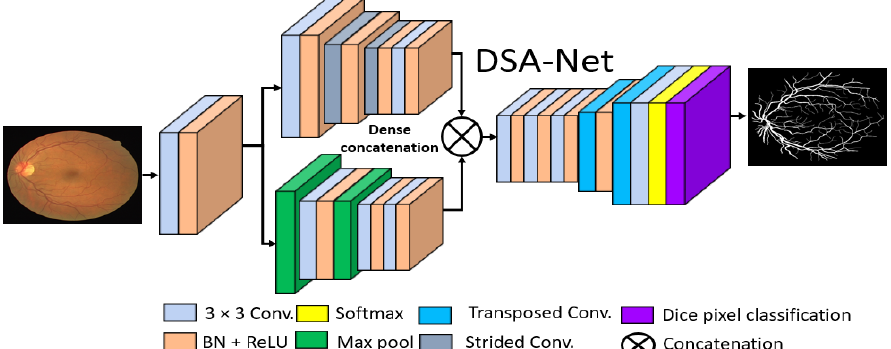
Figure 6. Proposed Dual-Stream Aggregation Network (DSA-Net). Abbreviations: DSA-Net, dual stream aggregation network, Conv., convolution, BN, batch normalization, ReLU, rectified linear unit.